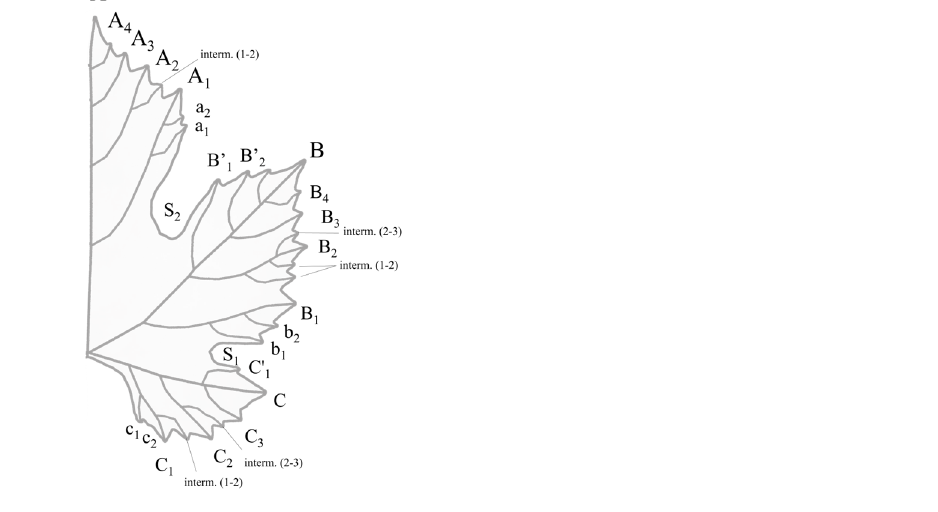
Figure 4. Ampelometric reference points suggested by Rodrigues [67] for evaluation of the leaf mor ‐ phological diversity.